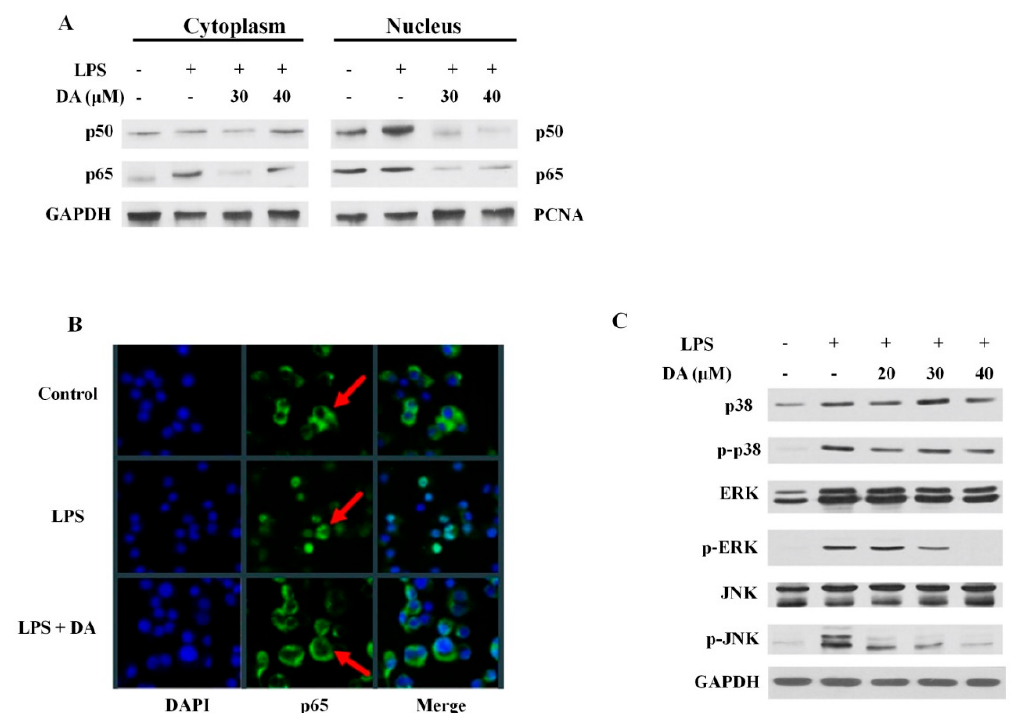
Figure 4. DA inhibits the activation of the NF κ B and MAPK pathways by LPS in Raw 264.7 cells. ( A ) cells were stimulated with LPS and then incubated with or without DA for the indicated amounts of time. Cytoplasmic and nuclear fractions and total cell lysates were analyzed through a Western blot assay. DA inhibited the activation of the NF κ B and MAPK pathways by LPS in Raw 264.7 cells; ( B ) nuclear localization of the p65 subunit of NF κ B was analyzed through immunofluorescence. Briefly, cells were fixed with 3.7% formaldehyde and permeabilized by incubating them with 0.1% Triton X-100. The cells were incubated with anti-NF κ B p65 antibodies overnight at 4 ◦ C, and then with goat anti-rabbit IgG-FITC for 1 h at room temperature in the dark. Next, the cells were incubated with DAPI mounting medium for 10 min and analyzed using a confocal microscope. Fluorescent images of the cytoplasmic and nuclear fractions were merged to locate p65. DA inhibited the translocation of p65 into the nucleus; ( C ) DA inhibits the activation of the MAPK pathway. Cells were incubated with LPS with or without DA for the specified amounts of time, and the levels of total and/or phosphorylated proteins involved in the MAPK pathway were analyzed through Western blot.